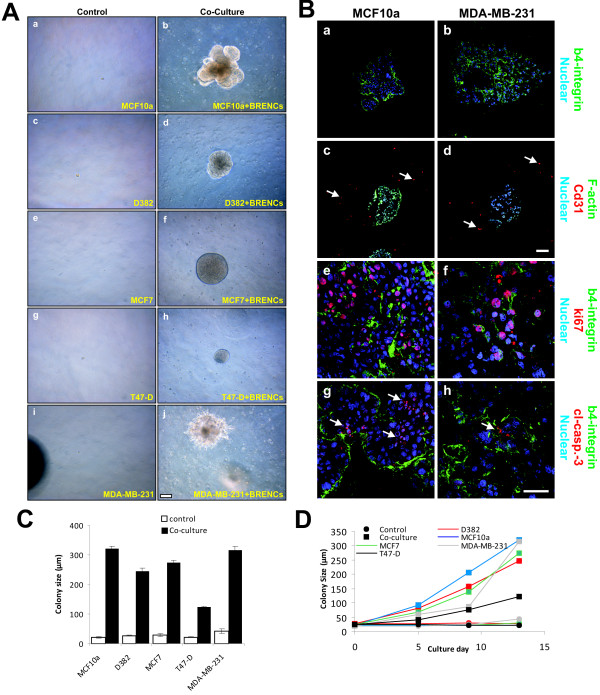
BRENCs induce clonal growth of normal and malignant breast epithelial cell lines. A) BRENCs generate positive environment for clonal growth of breast epithelial cells. MCF10A, D382, MCF7, T47-D and MDA-MB-231 cells were seeded at a clonal dilution, alone or in co-culture with BRENCs. When cultured alone there was very limited colony formation, most seeded cells stayed as non-proliferative single cells (a, c, e, g, i). In contrast, co-cultures of BRENCs with all cell lines resulted in dramatic increase in colony growth. MCF10A cells formed multiacinar-like structures (b), whereas D382 formed solid round colonies (d). both MCF7 and T47-D formed solid round colonies (f, h). MDA-MB-231 formed mesenchymal like colonies (j). Bar = 100 μm. B) Immunophenotypic characterization of endothelial-epithelial co-cultures. β4-integrin staining reveals the different phenotype of MCF10A and MDA-MB-231, where MCF10A forms dense multiacinar structures delineated by β4-integrin expression but MDA-MB-231 forms colonies of loosely connected cells with diffused staining pattern of β4-integrin. (a-b). Note the expression pattern of β4-integrin. CD31 staining shows the distribution of BRENCs around the colonies (c-d). ki67 expression levels are similar in both cell lines (d-e) and minimal expression of cleaved caspase 3 is seen (g-h) Bar = a-d 100 μm and e-h = 50 μm. C) Colony size is increased in co-cultures with BRENCs. Colony size (n > 100 for all cell lines) of epithelial cells co-cultured with BRENCs increased significantly compared with controls (P < 0.0001 for all co-cultures). MCF10A gave the biggest response, with a 15.5 fold increase in colony size, averaging at 320.6 μm diameter. Colony size varied greatly between cell lines. D) Colony growth over time. Most cell lines followed a linear growth pattern. Note however, the drastic change in growth of MDA-MB-231 cells after day 9 (light grey line).